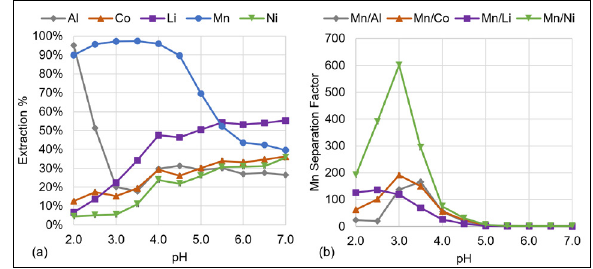
Effect of pH on the (a) extraction efficiency and (b) Mn separation factor of